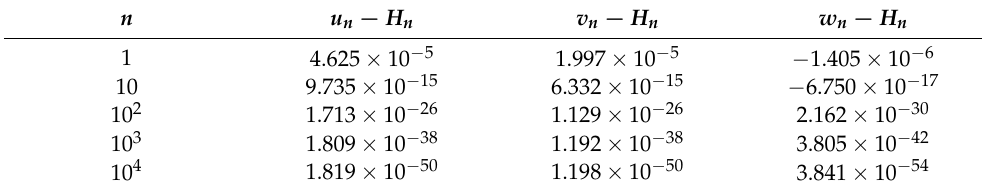
Table 1. Comparison of approximation Formulas